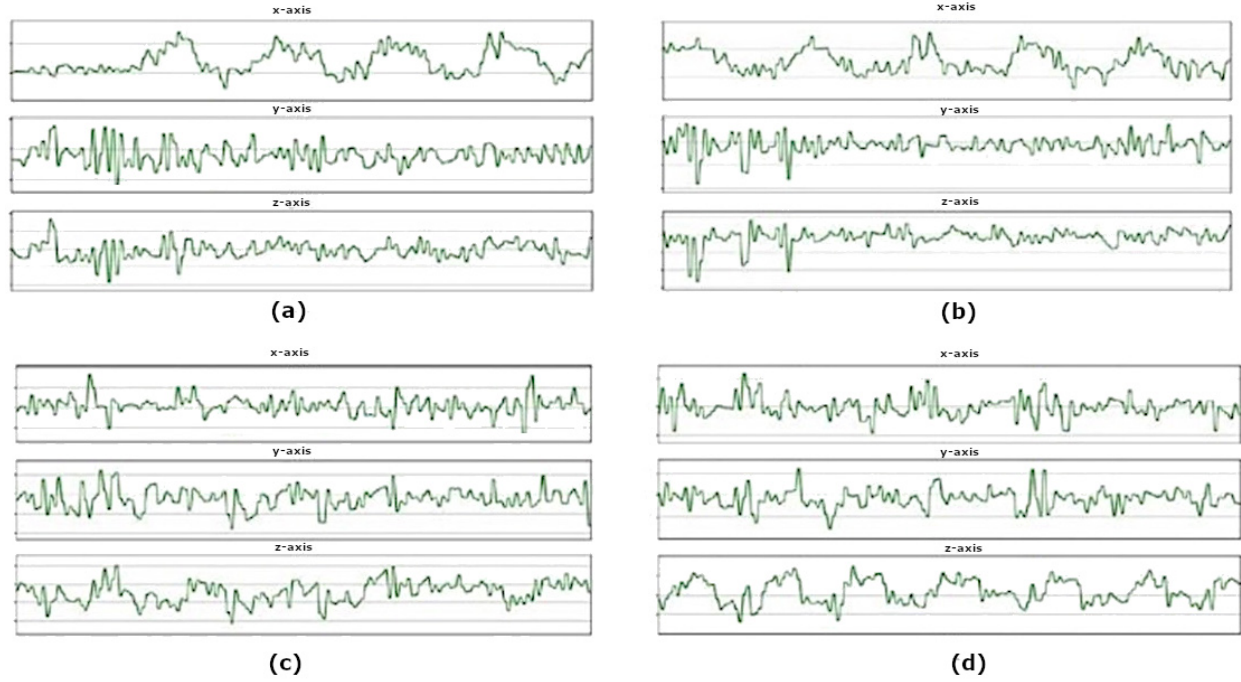
Figure 3. Accelerometer readings. ( a ) The x -axis of the accelerometer form peaks at each Right turn. ( b ) The Left turn creates an opposite pattern from Right turns as each turning point forms successive valleys upon the x -axis. ( c ) Accelerate event creates valleys on the z -axis of the accelerometer. ( d ) The Brake event indicates an opposite pattern where peaks are formed on the z -axis of the accelerometer at each braking